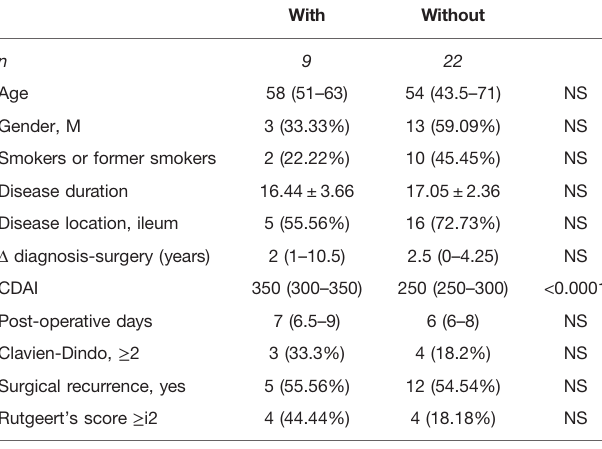
TABLE 1 | Demographic and clinical characteristics of CD patients with or without intra-abdominal fi